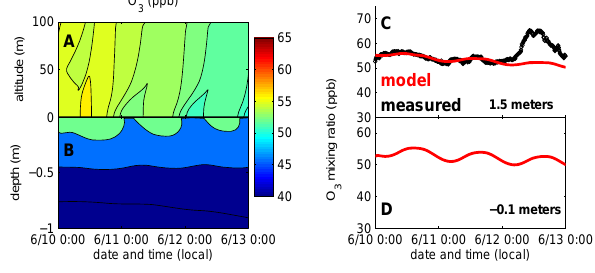
Fig. 9. Modeled O 3 mixing ratios in the atmosphere (A) and in- terstitial (B) air. Modeled mixing ratios in the atmosphere at an altitude of 1.5m above the snowpack are compared with measure- ments in (C) . Predicted interstitial air mixing ratios 10cm below the snow surface are shown in (D)